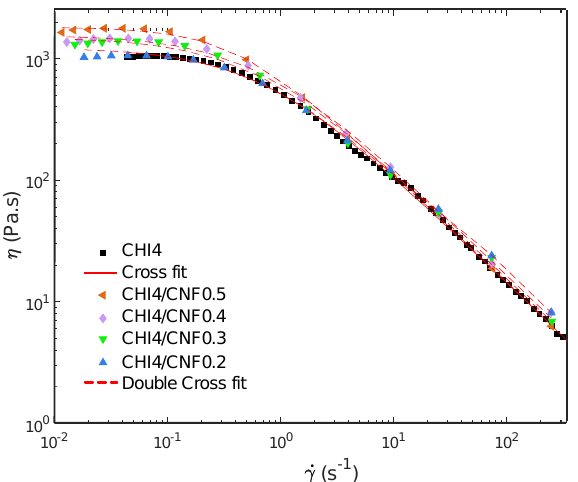
. γ ) of CNF-filled